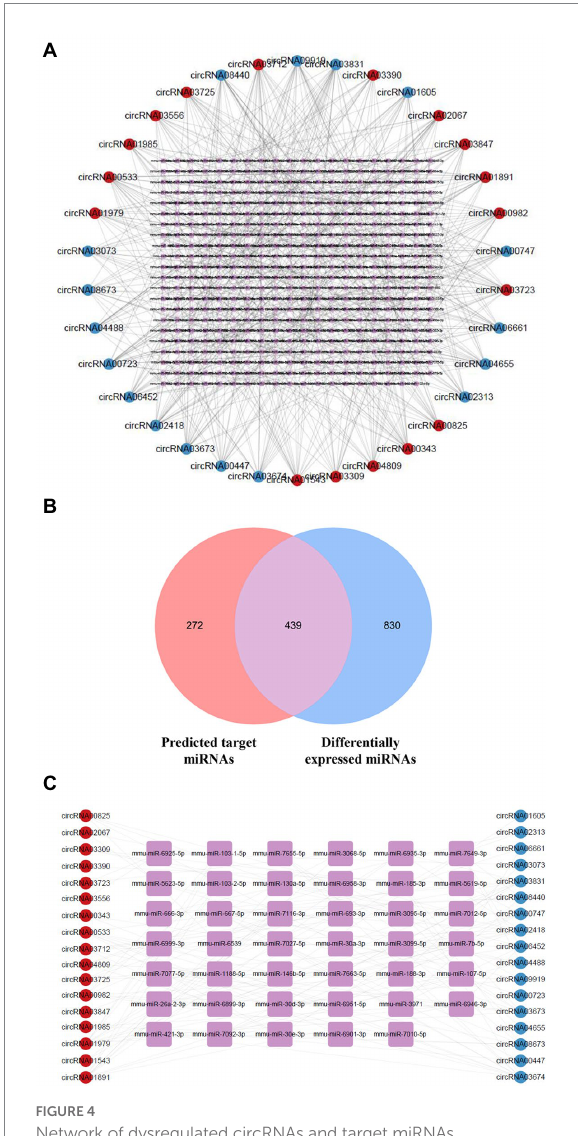
FIGURE 4 Network of dysregulated circRNAs and target miRNAs. (A) Network of dysregulated circRNAs and their predicted miRNAs using the database. Upregulated circRNAs are shown using red circles, downregulated circRNAs using blue circles, and potential miRNAs using purple squares. (B) Venn diagram of predicted target miRNAs and abnormally expressed miRNAs in 5 × FAD mice. The number of predicted miRNAs is shown in red, and the number of differentially expressed miRNAs is shown in blue. (C) Network of dysregulated circRNAs and key miRNAs selected by the Degree algorithm. Upregulated circRNAs are shown using red circles, downregulated circRNAs are shown using blue circles, and key miRNAs are shown using purple